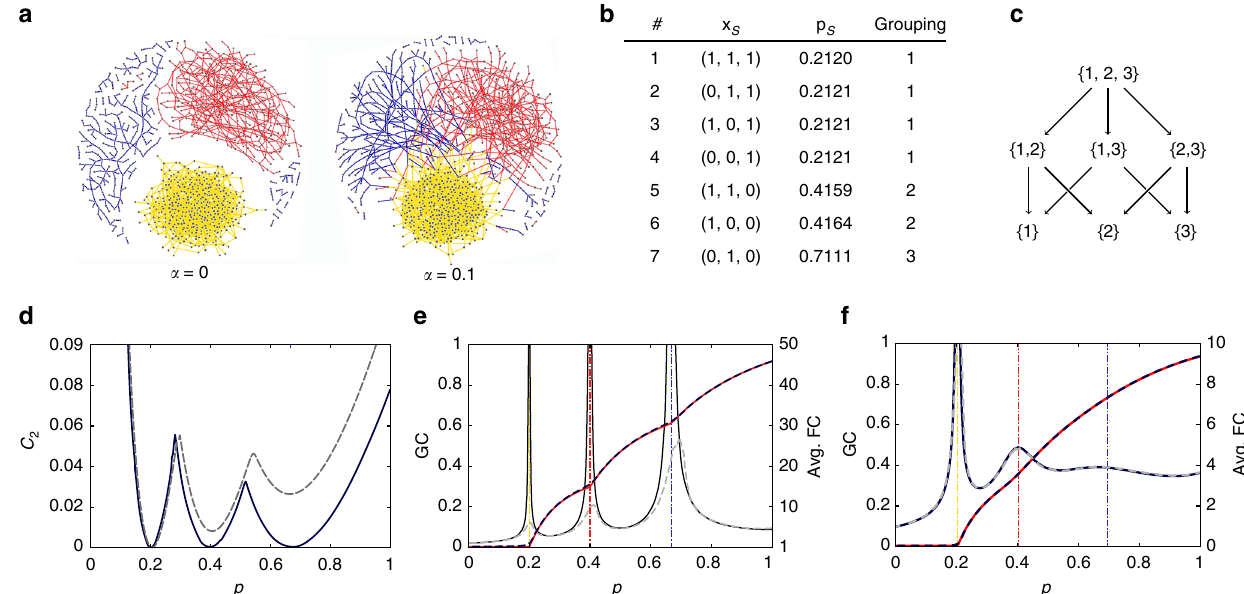
Fig. 4 Multiple phase transitions during percolation in the edge-coloured network model. a Samples of network topologies corresponding to the degree distribution given by Eq. (36) with α = 0 and α = 0.1. b The list of all secondary phase transitions and the colour subset indicators that correspond to them. c The partial order of all secondary phase transitions in a network with three colours. Arrows denote inclusion of the colour subsets. d Dependance of the exponent coef fi cient C 2 on the percolation parameter p for two vales of the parameter: α = 0 (solid line), and α = 0.1 (dashed line). e , f Left axis: The total size of all giant components as a function of percolation parameter p as obtained from the theory (red solid line) and simulations (black dashed line). Right axis: The weight-average size of fi nite connected components as obtained form the theory (black solid line) and simulations (grey dashed line). These results are obtained for degree distributions with: e α = 0, and f α = 0.1. The vertical guide lines indicate theoretical values for phase transition points